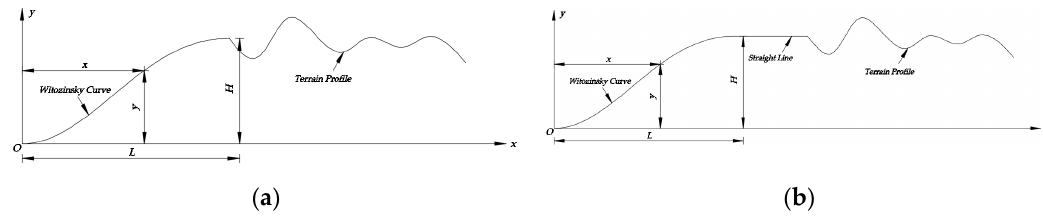
Figure 2. Terrain model BTS with / without horizontal straight line (Liu, et al., 2019). ( a ) BTS without horizontal straight line; ( b ) BTS with horizontal straight